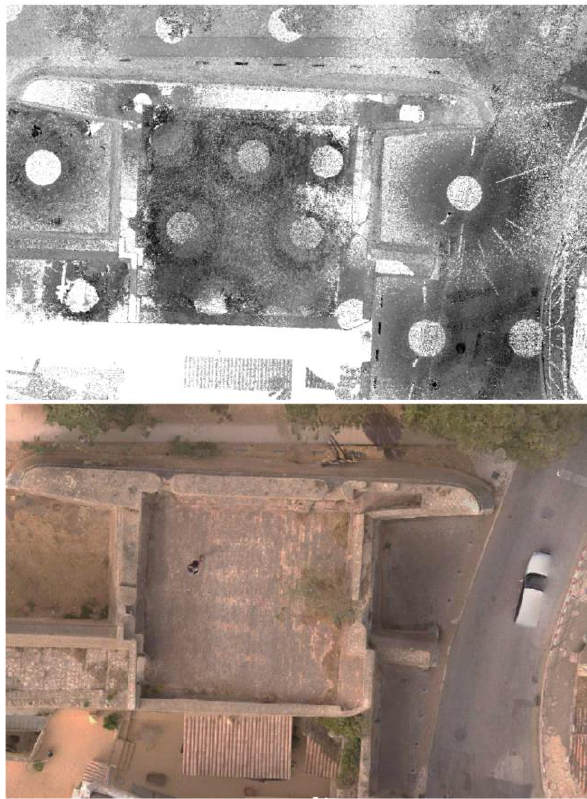
Figure 6. Top view orthoimages of “Baluarte da Porta dos quartos” from TLS (top) and photogrammetry (bottom)